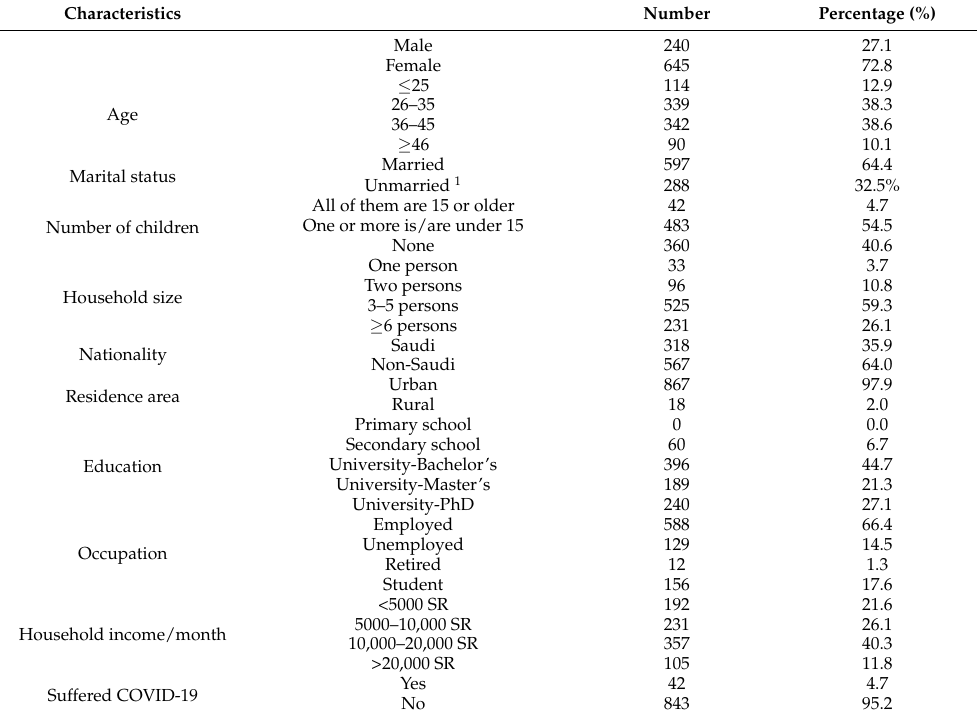
Table 1. Sociodemographic characteristics of the study